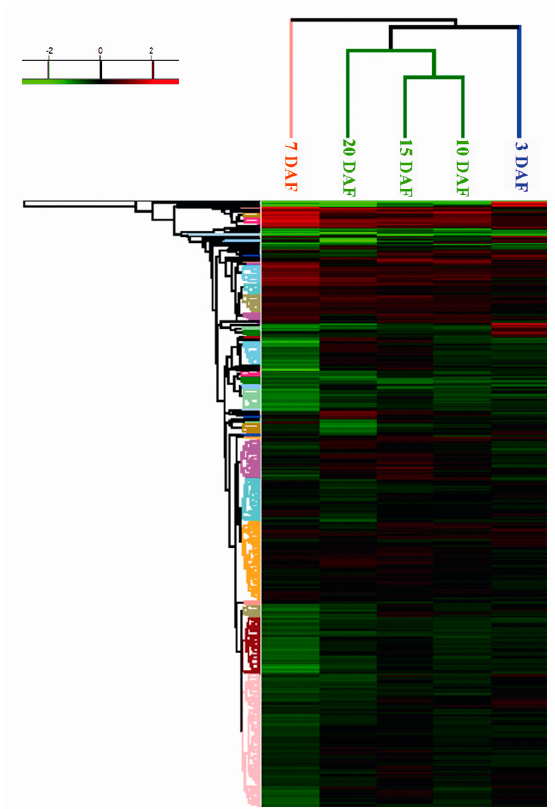
Figure 3. Cluster analysis of differentially expressed proteins in black rice leaves. The five samples with 848 differentially expressed proteins were clustered into three modules. The expression pattern was similar between 10 DAF and 15 DAF, and 15 DAF and 20 DAF. However, pattern in 7 DAF and 3 DAF showed different to that of 10, 15, and 20 DAF, respectively. Green, reduced expression compared to that observed in the REF (reference); Red, increased expression compared to that detected in the REF. Further analysis was performed for leaf proteins on 3 DAF, 7 DAF and 10 DAF and found that 88 differentially expressed proteins were shared between the 7/3 DAF comparison and 10/7 DAF comparison. There were 24 differentially expressed proteins out of 88 with known biological functions, and these proteins could be classified into six functional categories: gene regulated proteins (8, 33.3%), signal regulated proteins (4, 16.7%), carbohydrate metabolism-related proteins (4, 16.7%),